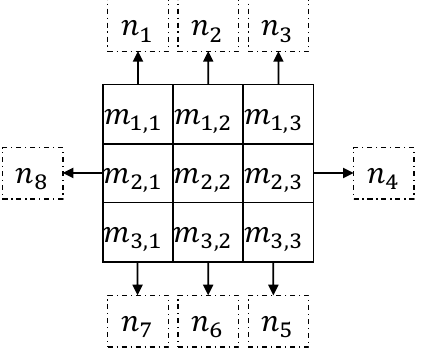
Figure 3. Example of matrix [ m i , j ] 3